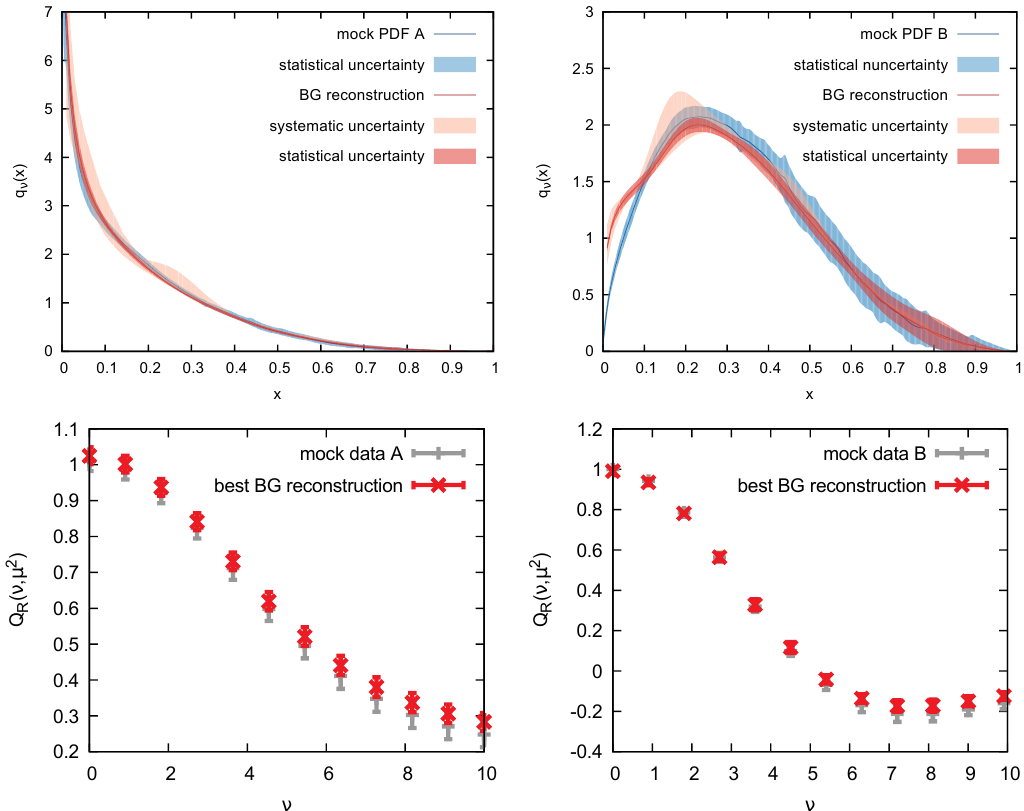
Figure 6 . x -space PDF’s reconstructed using the Backus-Gilbert (BG) method from N (cid:23) = 12 Io(cid:11)e-time data points on the interval (cid:23) = [0 ; 10] (top) as well as the input data (gray crosses) compared to the data arising from the reconstructed PDF (red crosses) in the bottom panels. The plots in the left column show the results for mock data based on a phenomenological PDF, while the right column from the modi(cid:12)ed scenario where the PDF vanishes at the origin. The reconstruction was performed with preconditioning exponents a = 0 : 35 and b = 2 for scenario A and a = 0 : 3 (cid:0) and b = 2 for scenario